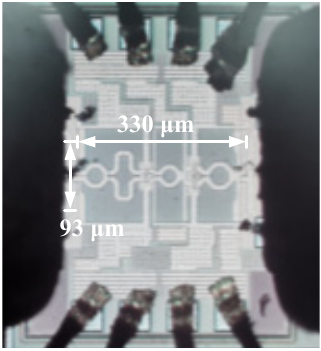
Figure 5. Chip micrograph of the PA. The S -parameter and output power measurement setup is shown in Figure 6. The S-parameters are measured from 200 MHz to 110 GHz using a N5251A network analyzer with frequency extenders. The output power is measured using a E8257D signal generator and a E4416A power meter.